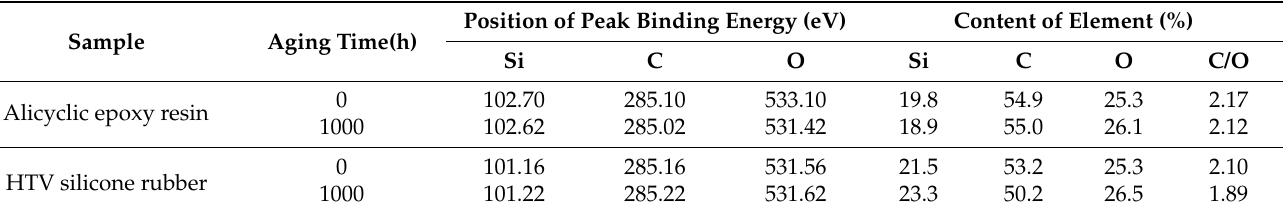
Table 3. Comparison of the position of peak binding energy and contents of three elements of both samples after 1000 h UV-A aging